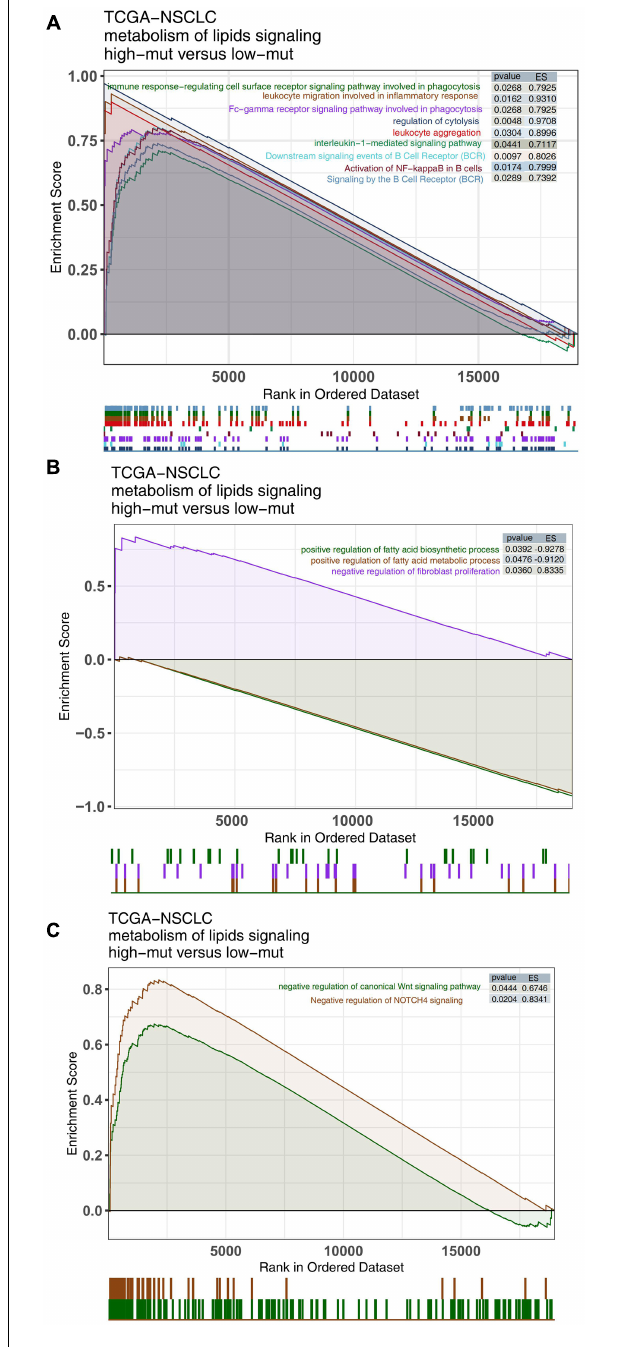
FIGURE 5 | Comparison of GSEA results between the high and low mutation groups in the TCGA cohort. GSEA-identified differences in immune cell (A) , exhaustion-related (B) , and oncogenic pathway activities (C) between the high and low mutation groups in the TCGA cohort.